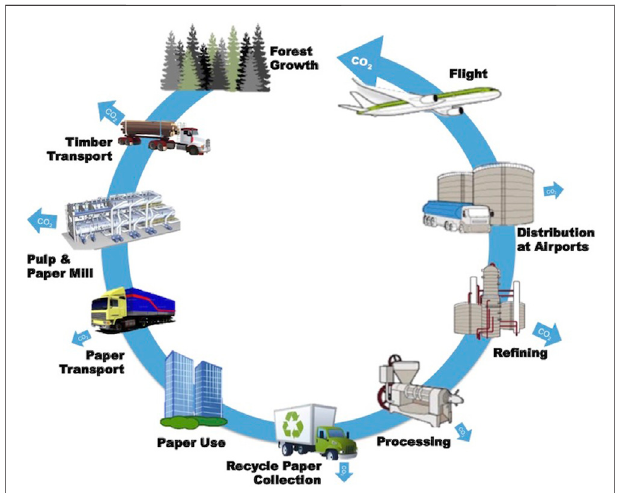
FIGURE1| Asimplediagramofthecarboncyclefortheproductionofjet fuel from recycle paper.